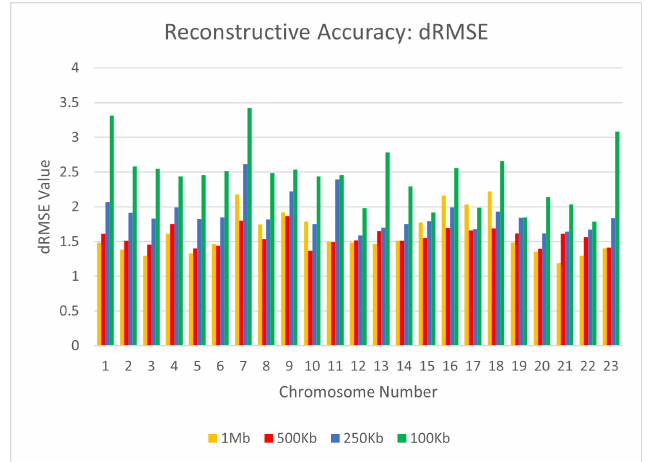
Figure 8. Comparison of dRMSE for CBCR on all 23 chromosomes at the four different resolutions.